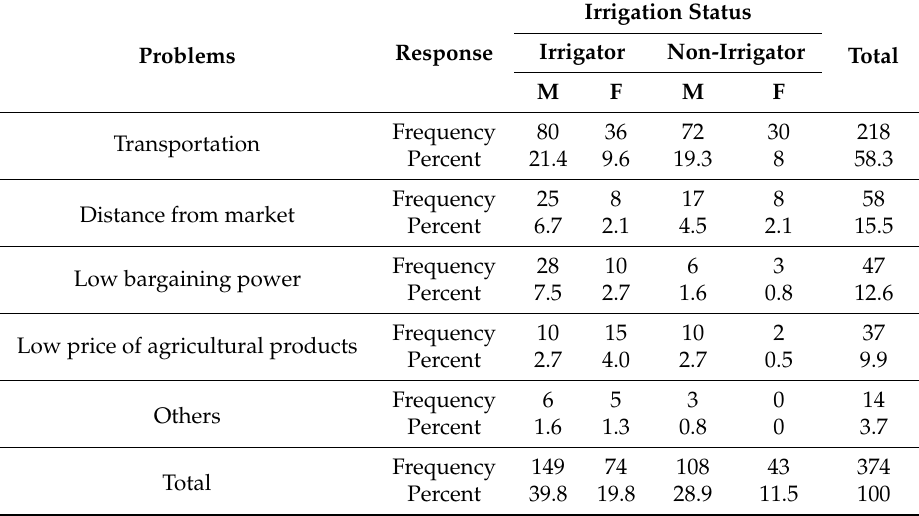
Table 9. Households’ response to market-related